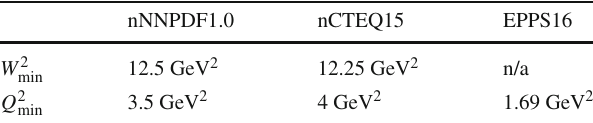
Table2 Thekinematicscutsin W 2 and Q 2 imposedinthenNNPDF1.0 analysis compared to those used in the nCTEQ15 and EPPS16 fits nNNPDF1.0